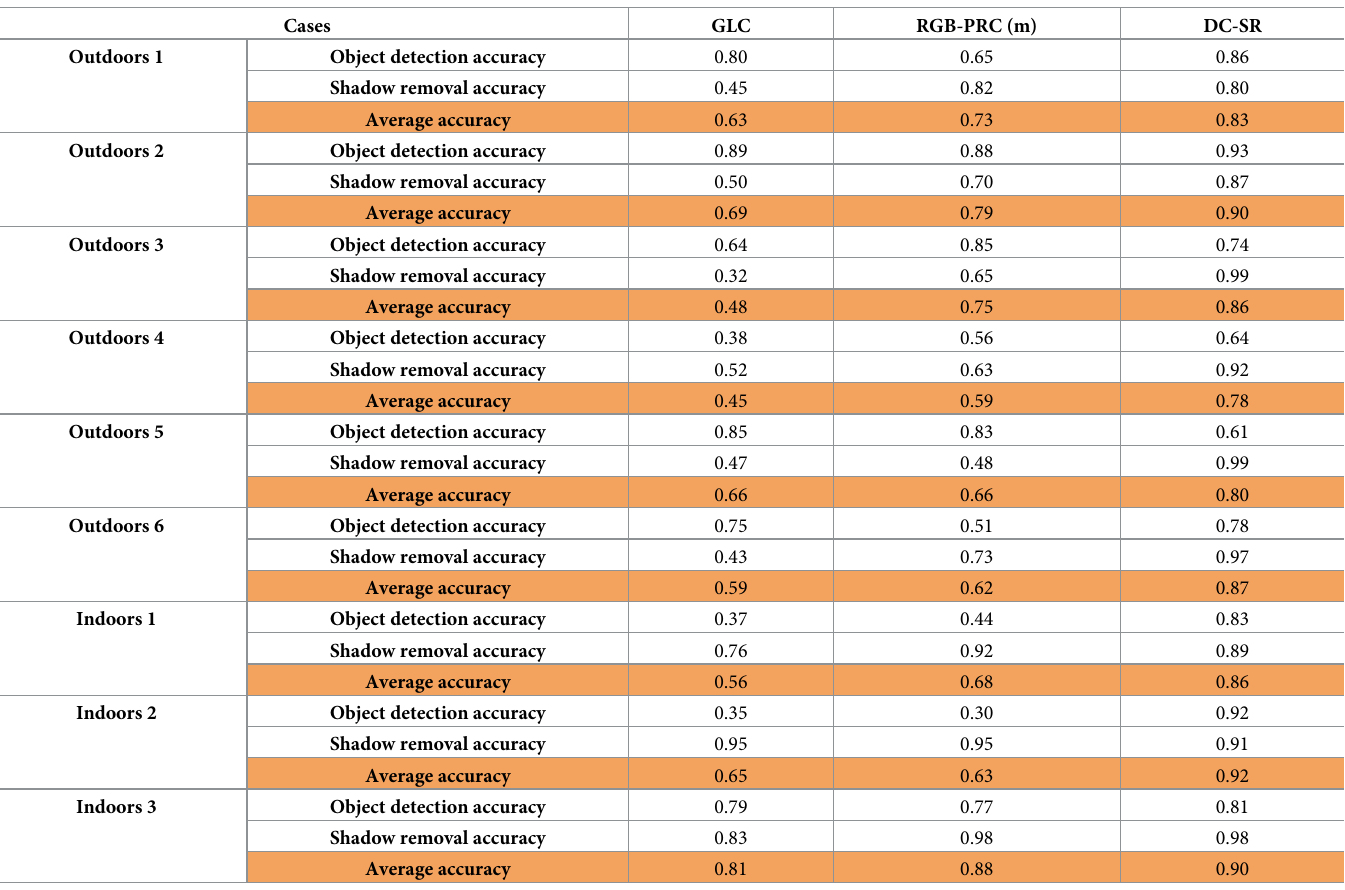
Table 1. Accuracy